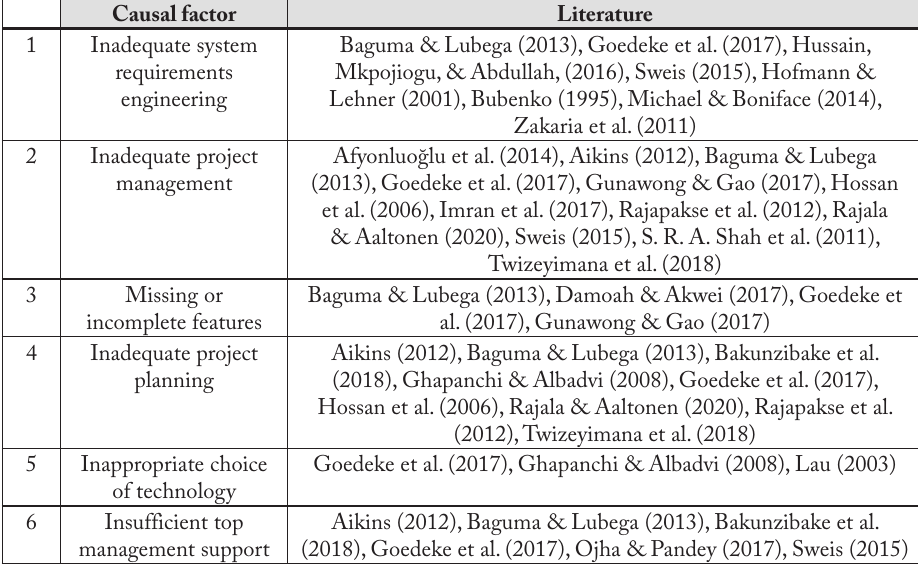
Table 1: Causal factors identified in existing